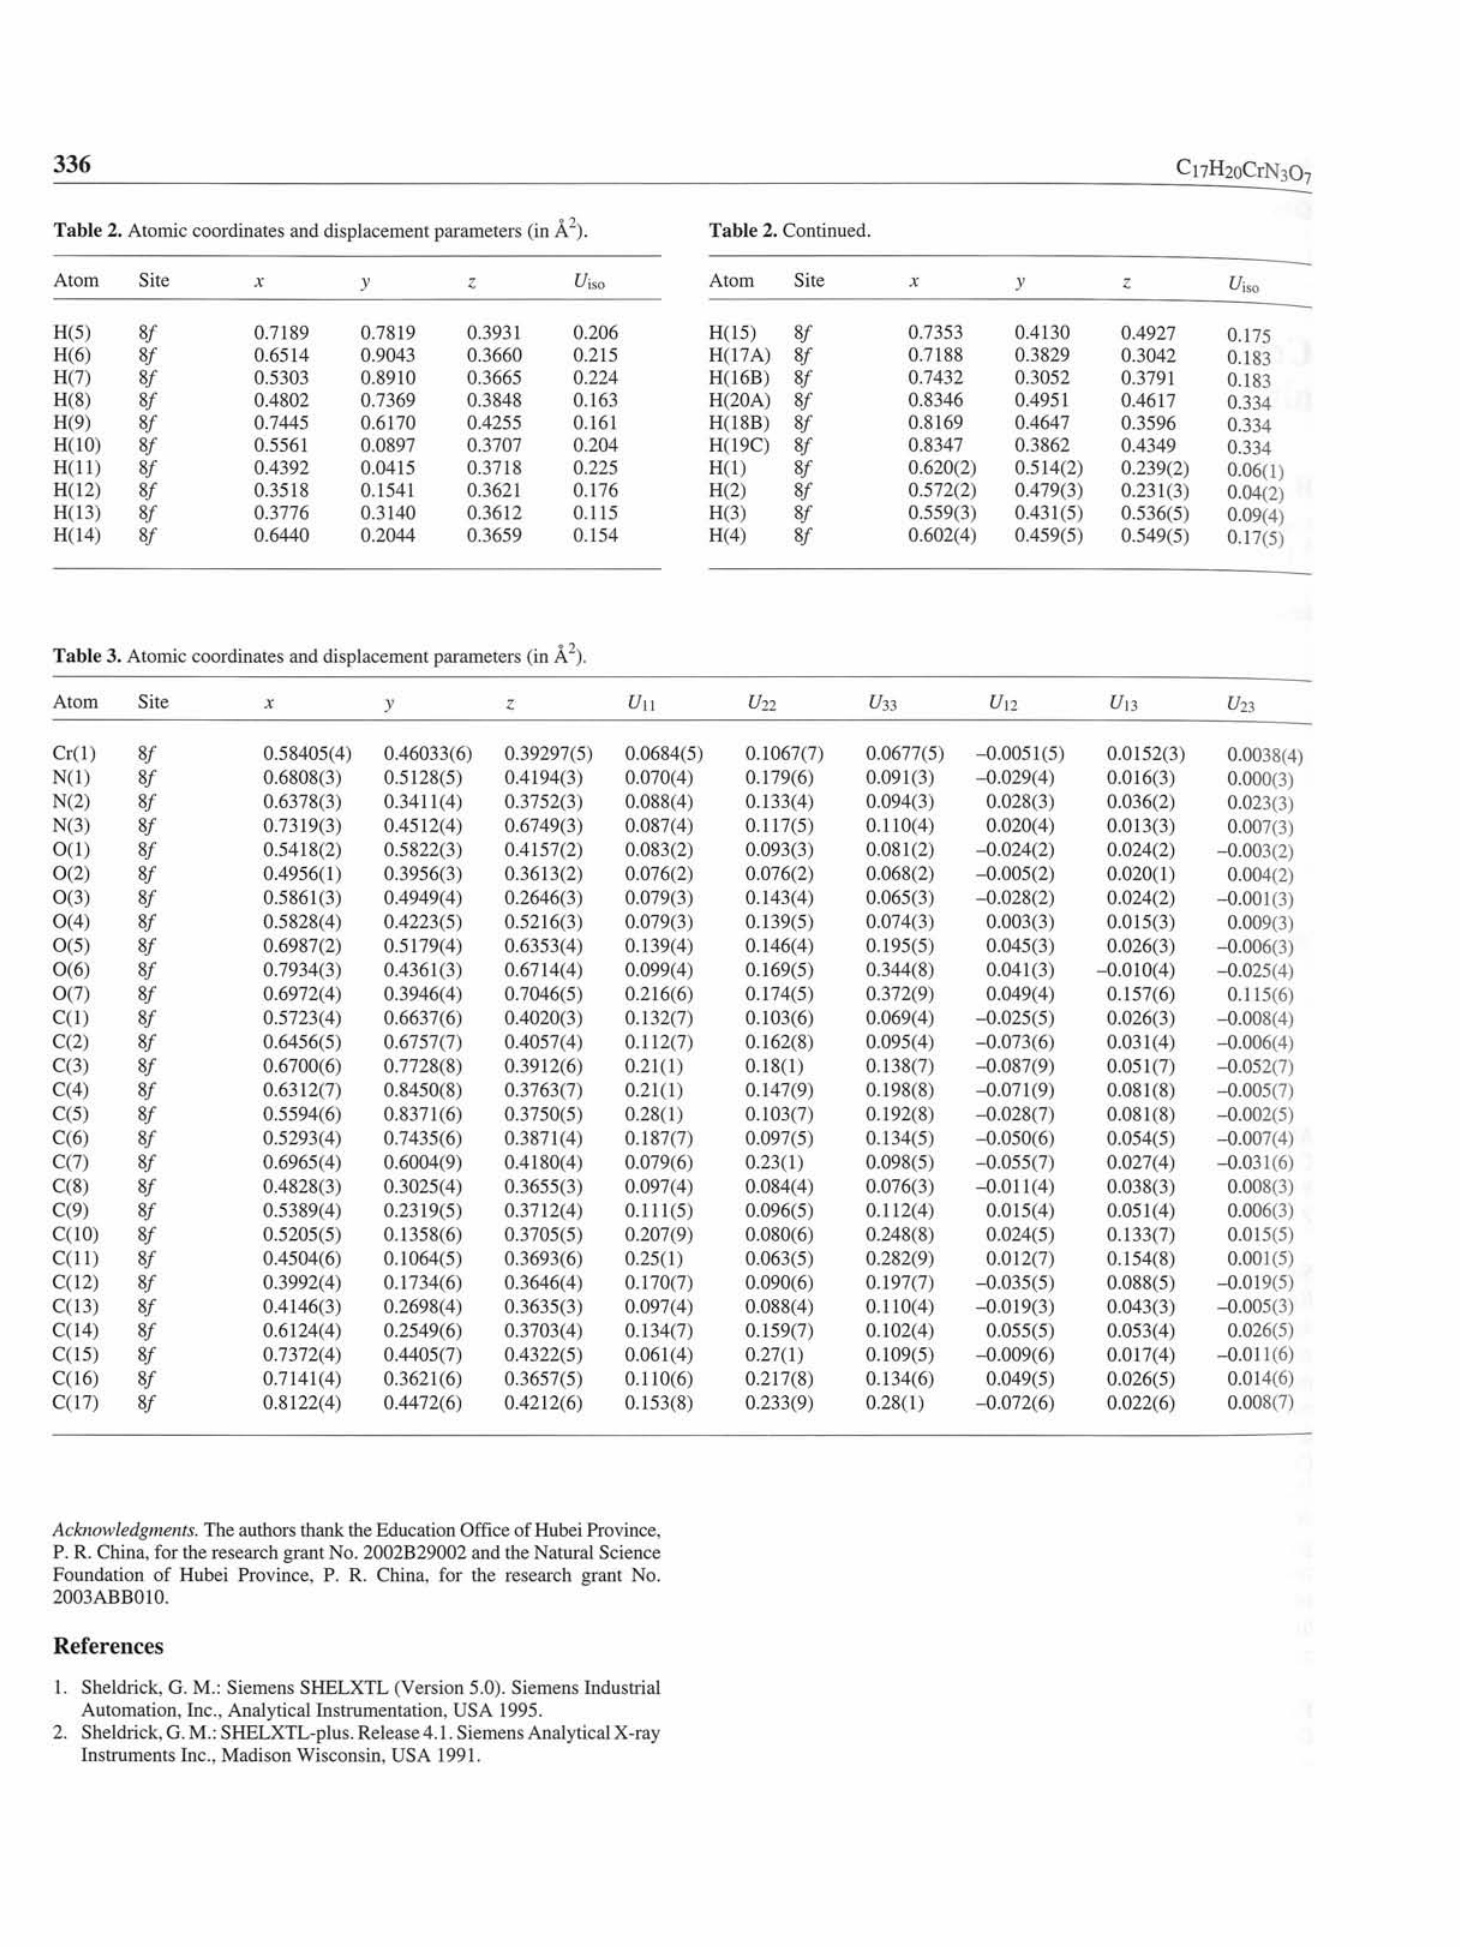
Table 3. Atomic coordinates and displacement parameters (in Á 2